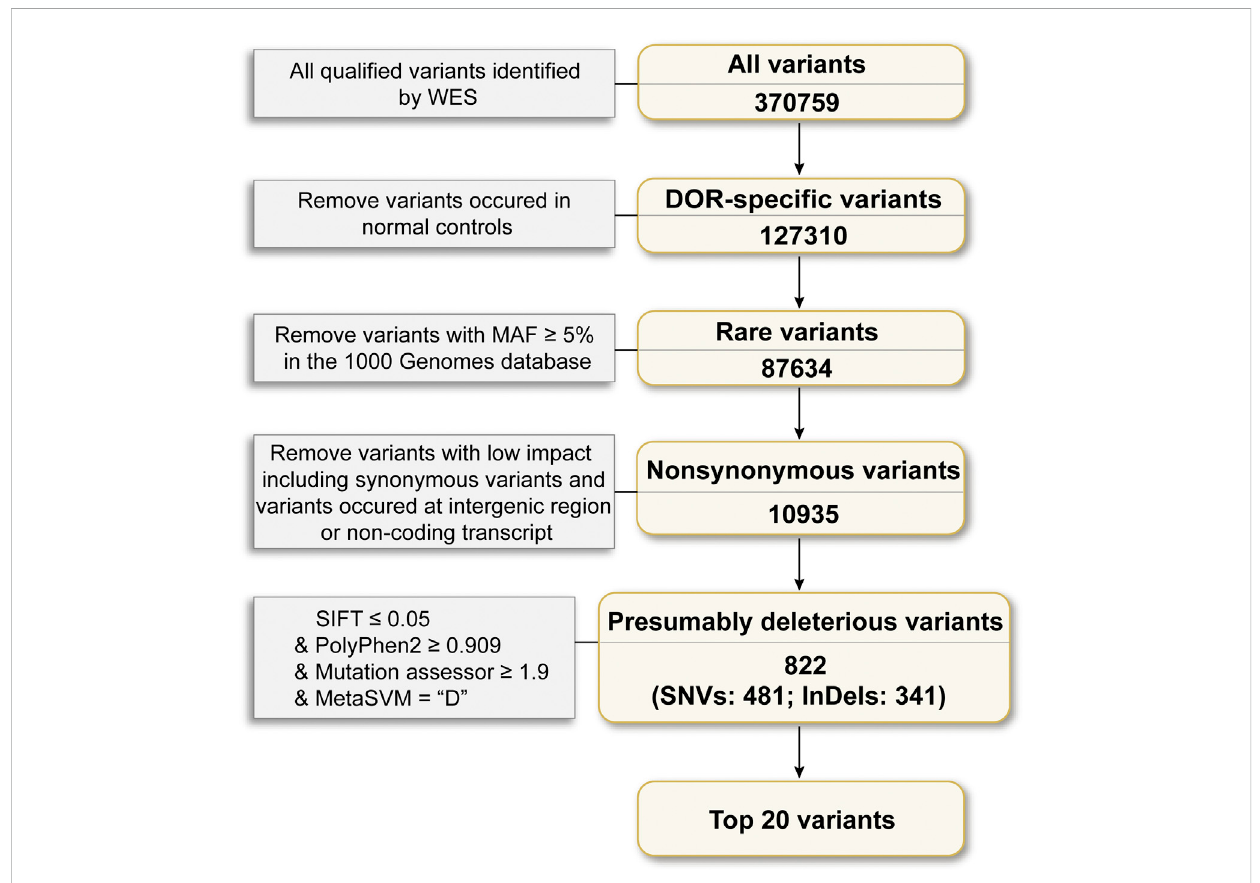
FIGURE 1 Framework ofWES data analysis.Of thequali fi edvariants,the variants1) identi fi edinnormalsamples; 2)MAF > 5%inthe 1,000 Genome database; 3) in the non-coding regions; 4) predicted as no impact were removed, and top 20 mutated variants were fi nally